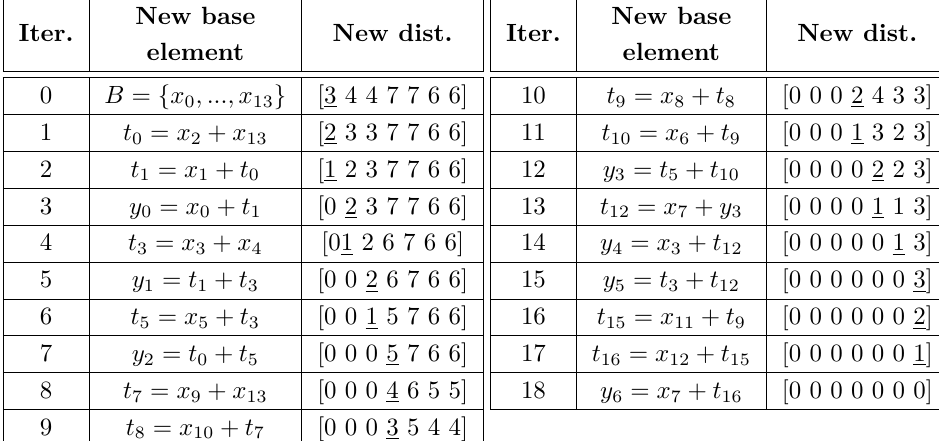
Table 3: Computations sequence when applying A1 algorithm to matrix M . B refers to the initialized base elements, x i refers to the input signals ∀ i ∈ { 0 , ..., 13 } , y j refers to the targets ∀ j ∈ { 0 , ..., 6 } and t k refers to the temporary intermediate gates ∀ k ∈ N